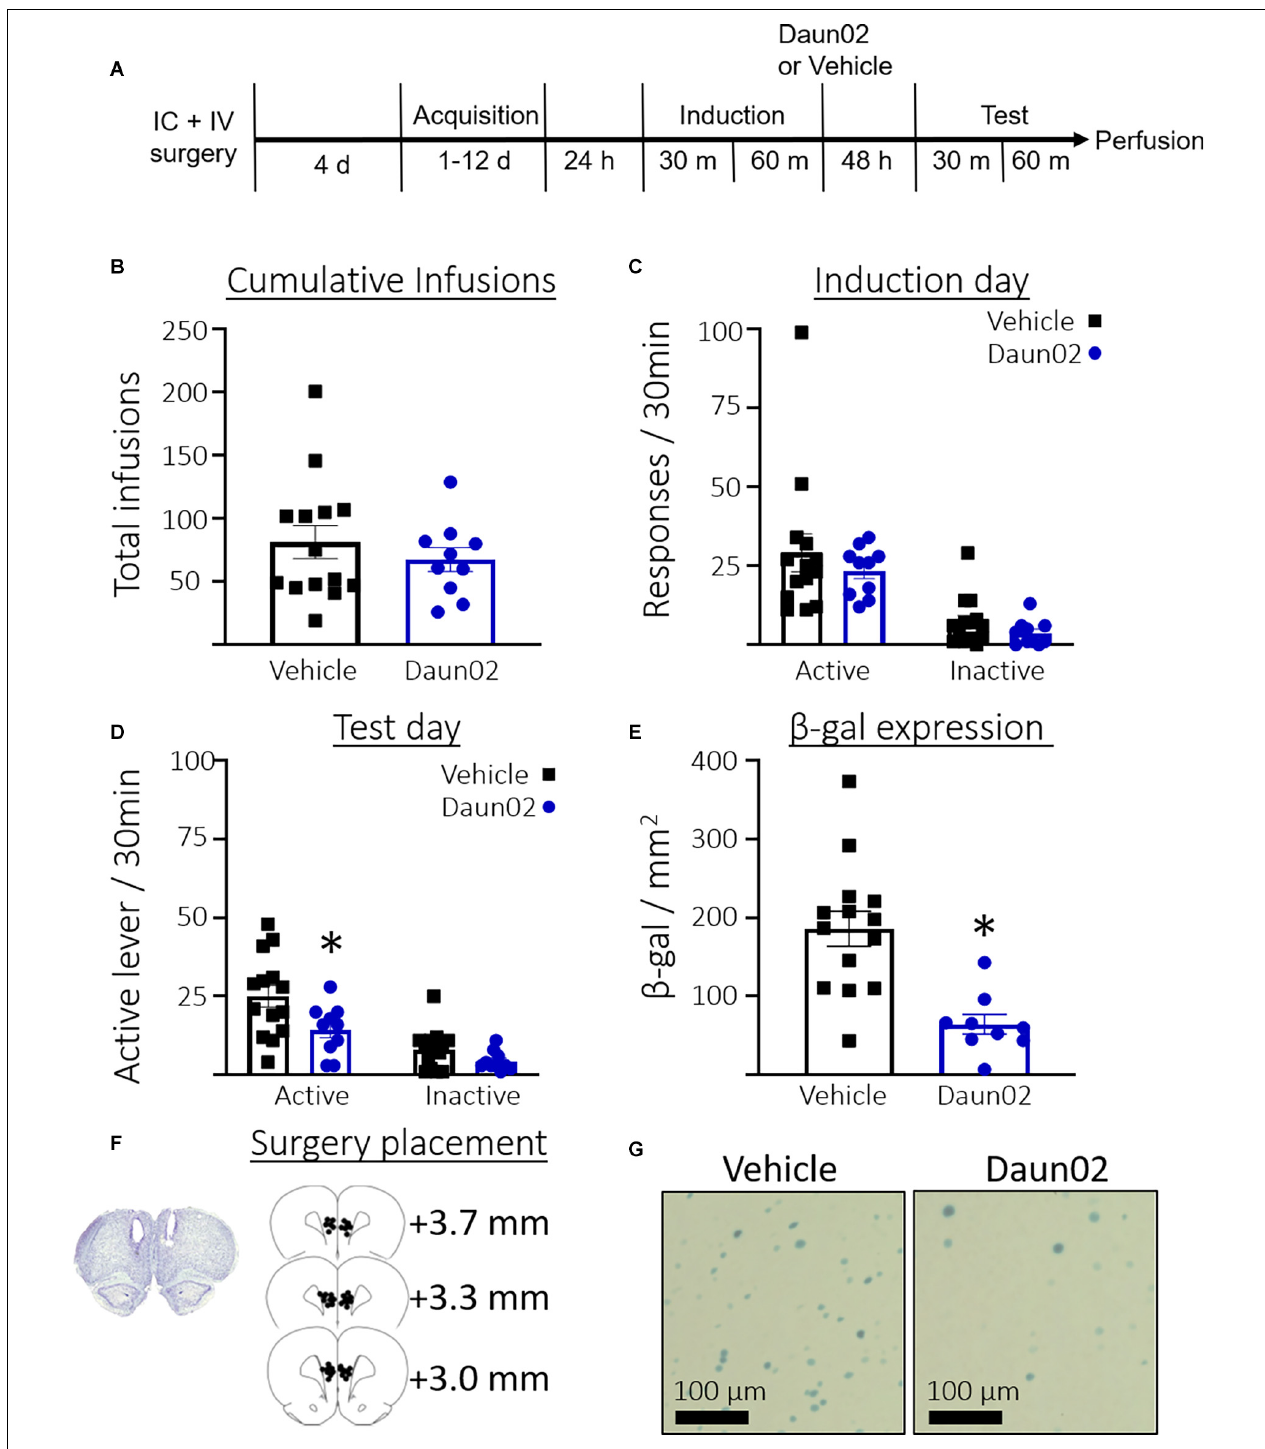
FIGURE 2 | Experiment 2: Role of PL ensembles after acquisition of cocaine seeking. (A) Timeline showing the behavioral procedure. (B) The number of total infusions earned across all acquisition days between rats assigned to either the vehicle or Daun02 condition. (C) The number of active and inactive lever responses in the induction session between rats assigned to either the vehicle or Daun02 condition. (D) Number of active and inactive lever responses in the test session between rats that received either vehicle or Daun02. (E) Number of β -gal positive nuclei per mm 2 in the PL between rats that received either vehicle or Daun02, with representative images of β -gal expression. (F) Cannula placement. (G) Representative images showing β -gal labeling in the PL. Data are presented as mean ± SEM ( n = 14–10 per group). ∗ p < 0.05 compared to vehicle-treated controls.